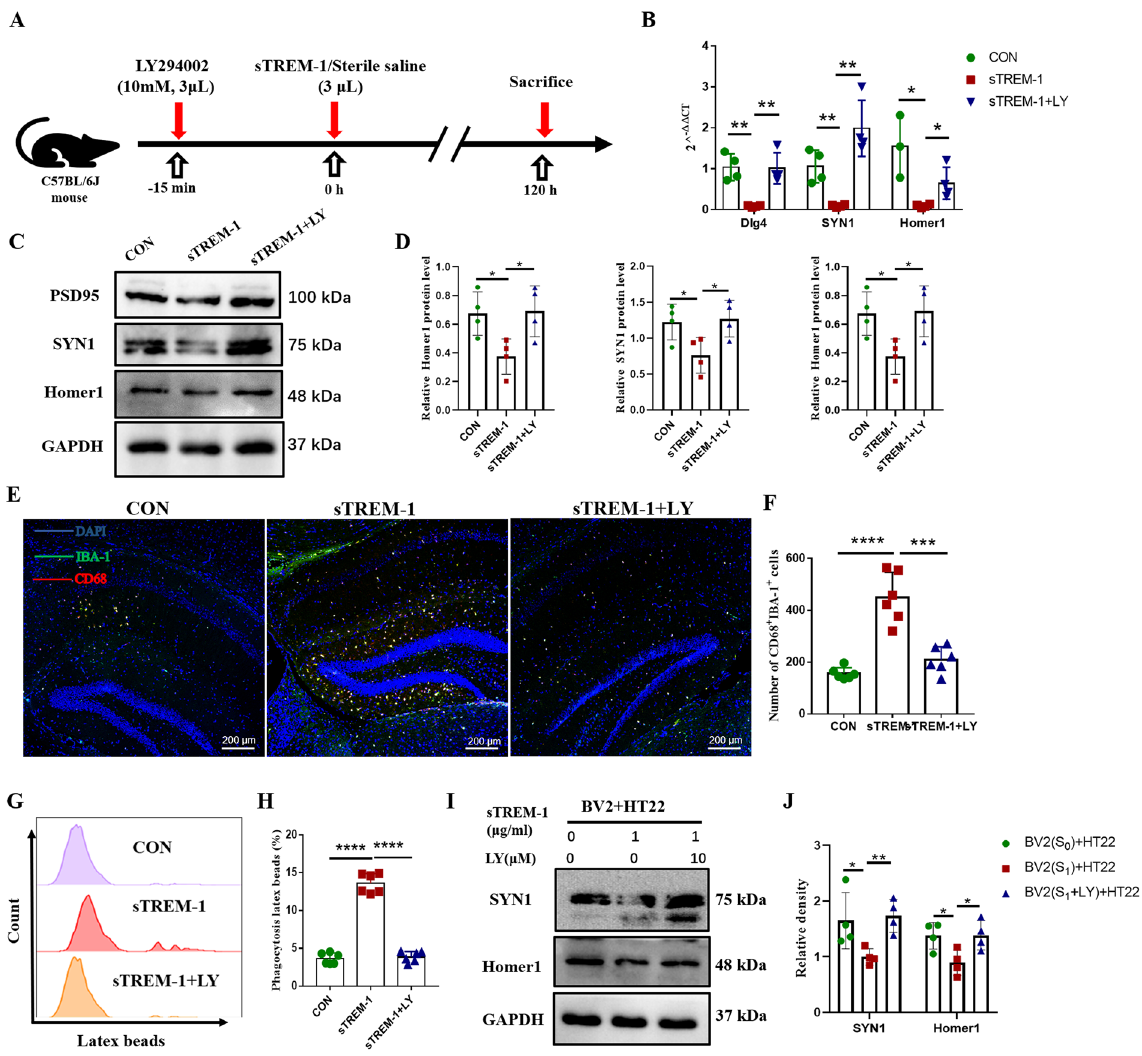
Figure 7. Inhibition of the PI3K–AKT pathway attenuates the phagocytic activation of microglia induced by sTREM-1. (A) The experimental plan was visualized. (B) The mRNA expression levels of Dlg4 , SYN1, and Homer1 in mouse hippocampus detected by Q-PCR, n = 4. (C) Representative western blot images of Dlg4, SYN1, and Homer1 protein expression in mouse hippocampus. (D) Quantitative analysis of PSD95, SYN1, and Homer1 protein level in mouse hippocampus, n = 4. (E) Representative image of IBA-1 and CD68 immunofluorescence double staining of the hippocampus in per group mice, scale bar is 200 μm. (F) Quantitative analysis of IBA-1 and CD68 double-positive cells, n = 6. (G) Representative histograms of BV2 cells phagocytosis of latex beads in different treatment groups detected by flow cytometry. (H) Phagocytosis in different BV2 cells groups detected by flow cytometry. (I) Representative western blot images of SYN1 and Homer1 protein expression in different HT22 cells groups. (J) Quantitative analysis of SYN1 and Homer1 protein level in different HT22 cells groups. Data are presented as means ± SEM of at least three separate experiments, * P < 0.05, ** P < 0.01, *** P < 0.001, **** P < sTREM-1, a 27 kDa protein composed of the extracellular domain of mTREM-1, is present in various body fluids and was initially identified as a biomarker of infectious diseases 79–84 . Later on, it was discovered that plasma sTREM-1 participates in neurodegeneration and brain injury. In patients with AD, plasma sTREM-1 is signifi- cantly increased and has been associated with disease progression, dementia, and total Tau levels 85 . Xin-Gang Sun et al. reported that the increase of sTREM-1 is positively related to the severity of early brain injury induced by subarachnoid hemorrhage 29 , while its inhibition can impede the activation of microglia, reduce the destruction of the blood–brain barrier and neuronal damage, and improve short-term and long-term neurological function 86–88 . Serum sTREM-1 has been considered a surrogate index for evaluating the severity and functional prognosis of patients with acute ischemic stroke 31 . A previous study indicated an increased TREM-1 in serum, spleen, and lymph nodes of B6.lpr mice. Apart from this, increased serum sTREM-1 was observed in patients with increased NPSLE compared with healthy subjects and was positively correlated with the severity of the disease 46 . In addition, the levels of sTREM-1 in the serum, brain tissue, and cerebrospinal fluid of NPSLE mice were also